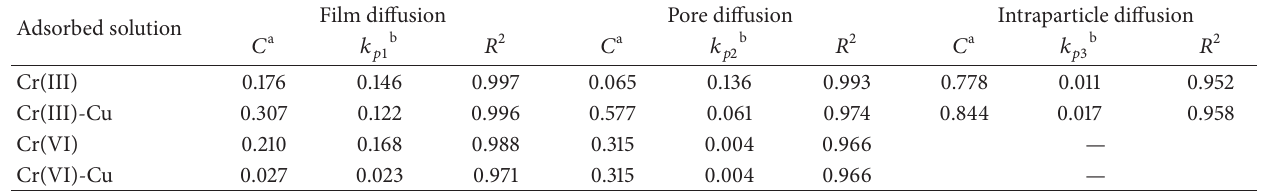
Table 2: Intraparticle diffusion model for Cr(III) and Cr(VI) adsorption in single and binary solution. Adsorbed